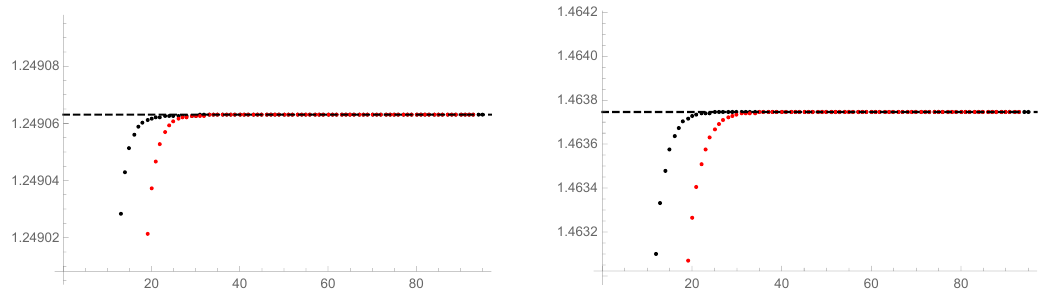
Figure 13 . Plot of sequence ˜ s k in (4.62) for the PCF model with N = 4 (left, black) and N = 5 (right, black) as well as their respective second Richardson transforms (red). The dashed line is the predicted asymptotic